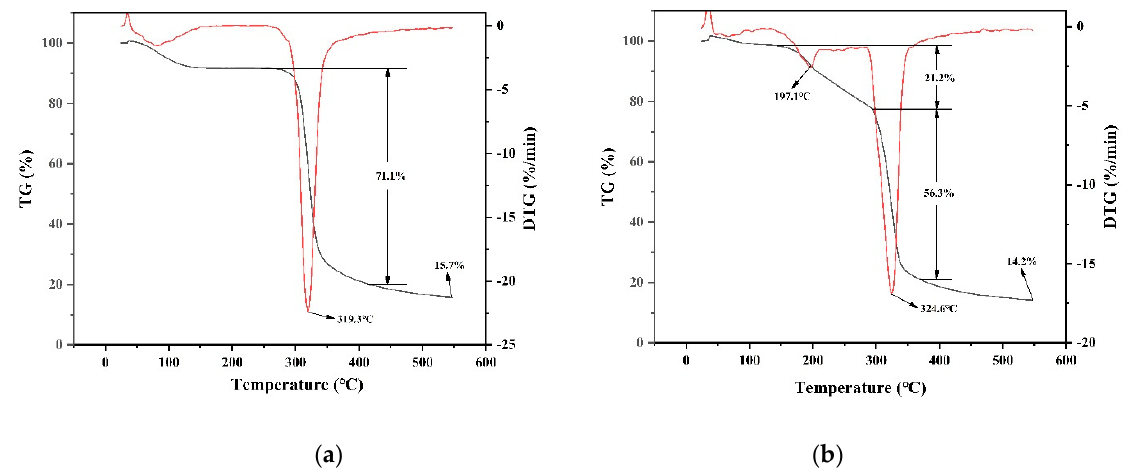
Figure 2. TG and DTG curves of pristine starch ( a ) and plasticized starch ( b ).